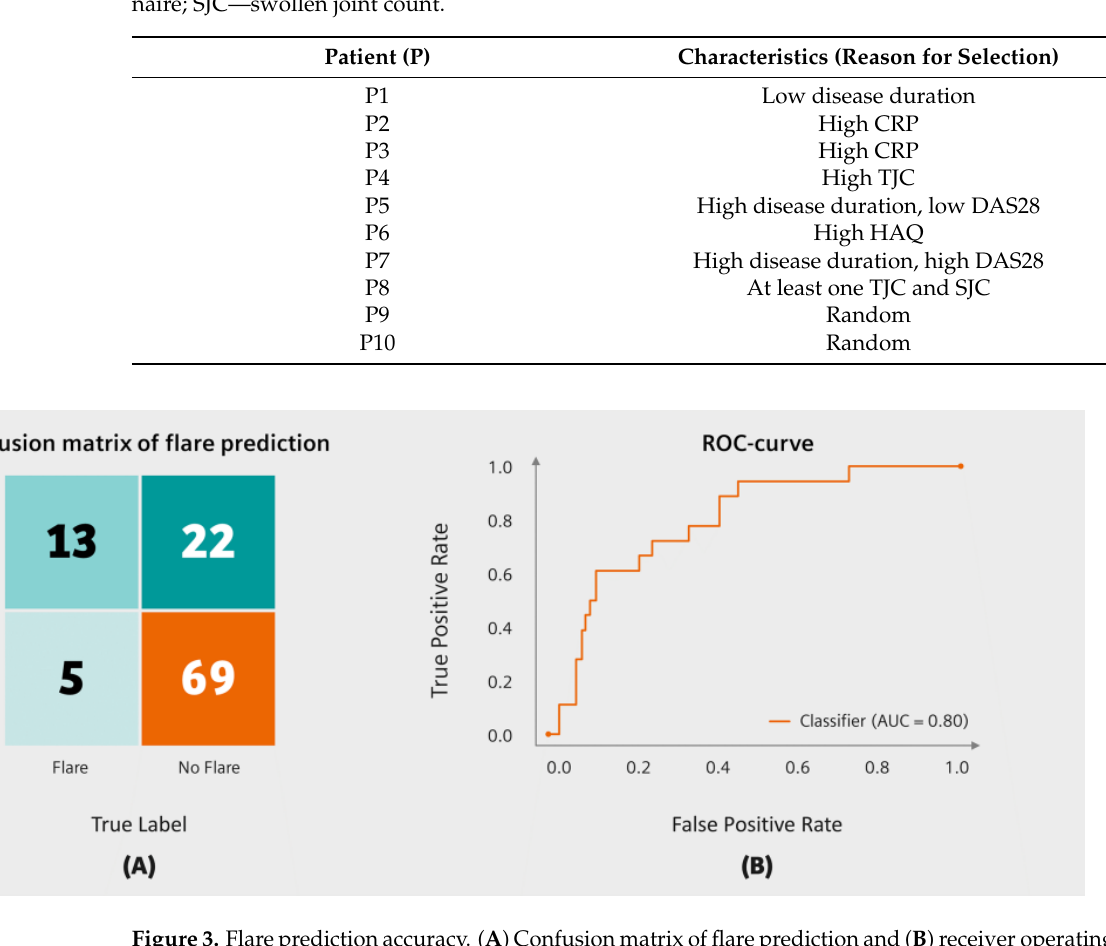
Table 3. Patient characteristics of the 10 patients included in part 2. CRP — C-reactive protein; DAS28 — disease activity score 28 joints; TJC — tender joint count; HAQ — health assessment ques- tionnaire; SJC — swollen joint count.